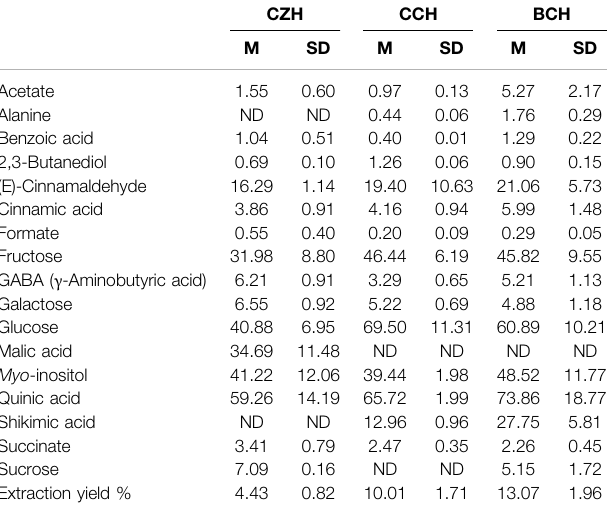
TABLE 3 | Mean concentrations (M) and corresponding standard deviations (SD) of metabolites contained in aqueous cinnamon extracts dissolved in D 2 O as determined from 1 H-NMR spectra. Concentrations of metabolites are expressed in mg/g of extract. M and SD of the extraction yields are also reported. Resultsare reported as the mean and SD of three independent